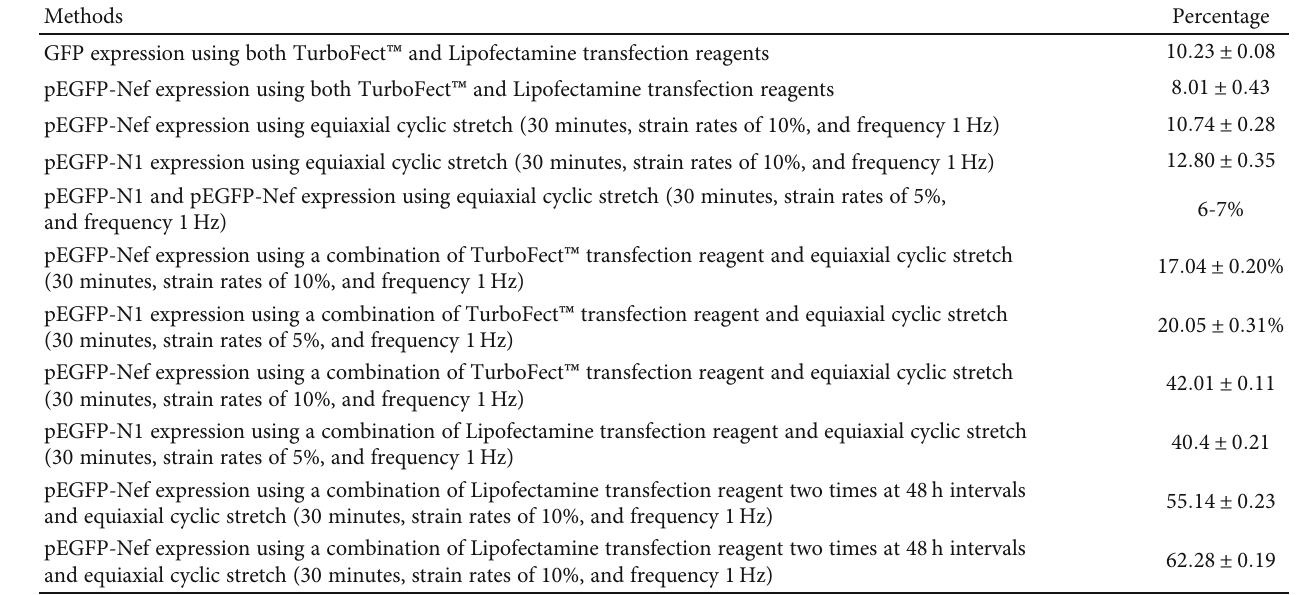
Table 3: Flow cytometry analysis of gene expression under mechanical and chemical treatments in MSCs. Methods Percentage GFP expression using both TurboFect ™ and Lipofectamine transfection